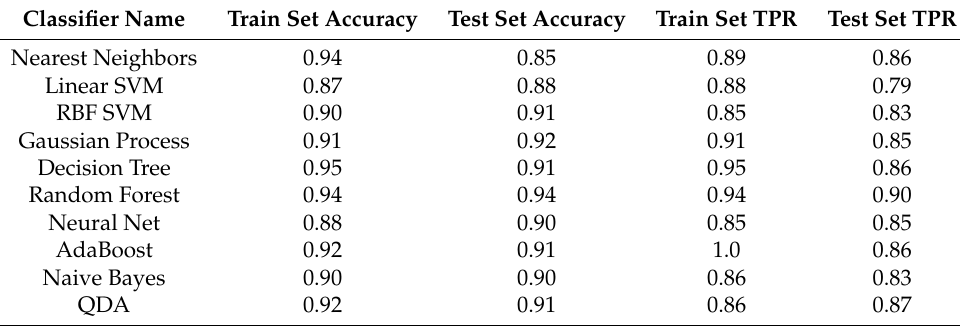
Table 3. Accuracy of apple fruit pixels classifier.